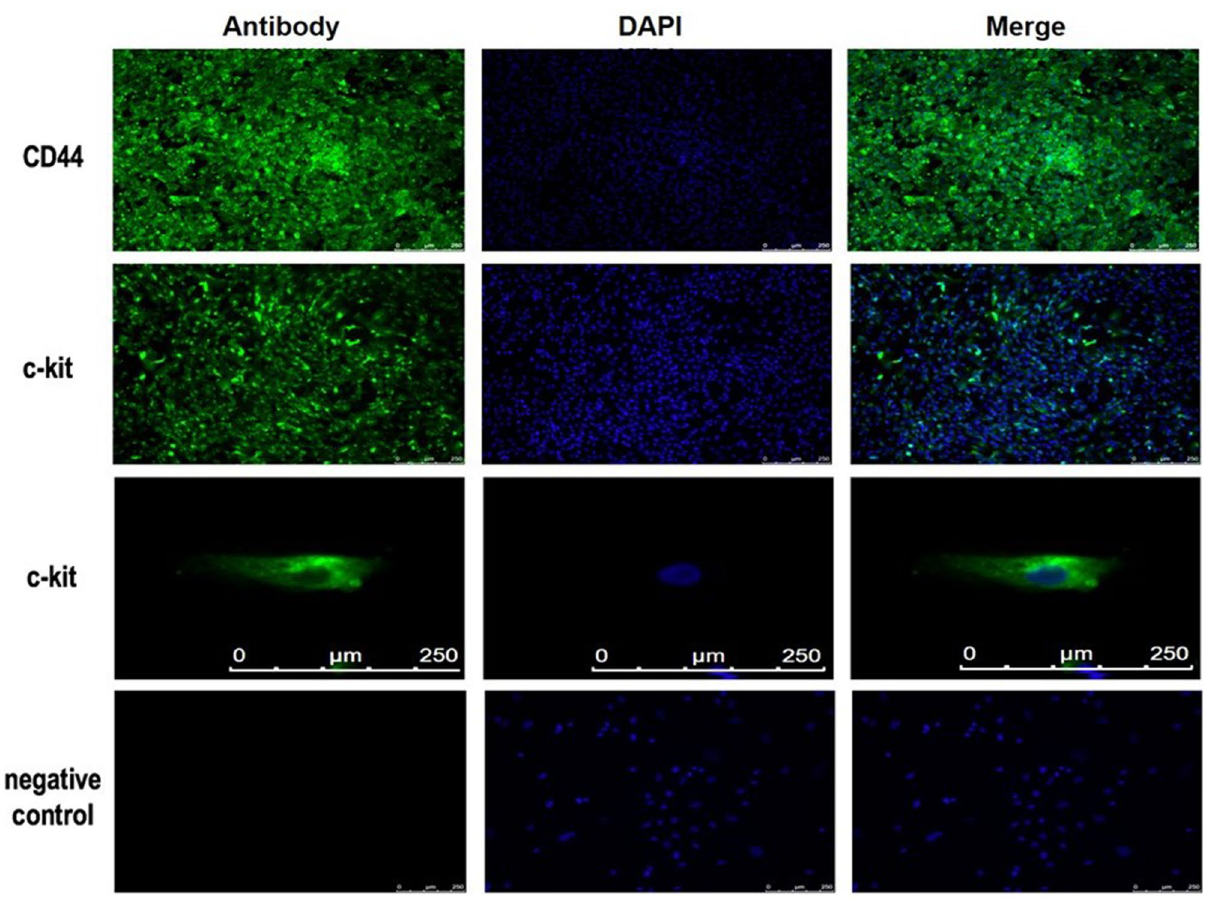
Figure 2. Immunocytochemistry staining of surface marker of hAFSC. hAFSC expressed enormous CD44 and c-kit, markers of stem cell. hAFSC human amniotic fluid stem